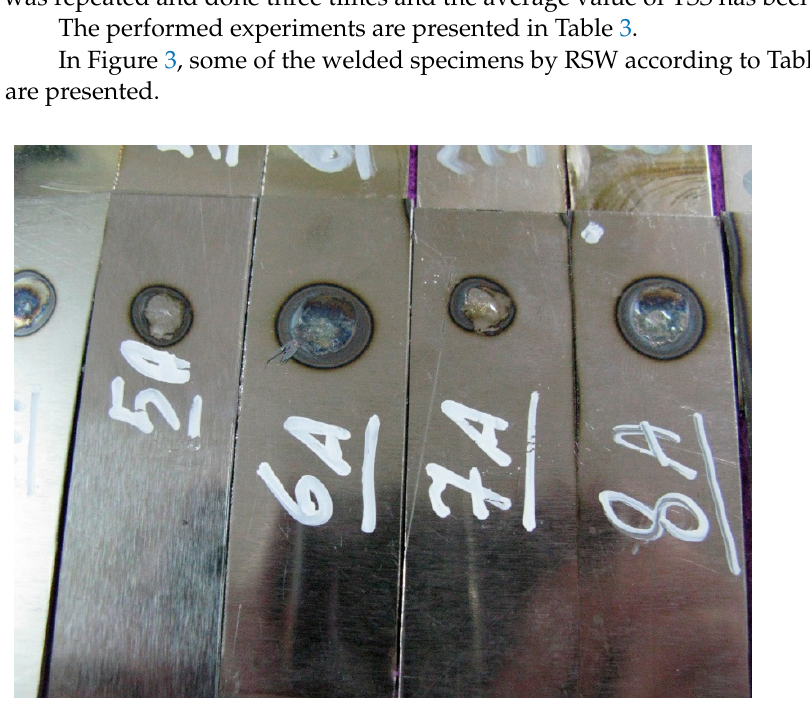
( b ) Figure 4. Two failure modes after tensile shear tests: ( a ) interfacial mode and ( b ) pullout mode. In Table 4, The TSS and failure modes after tensile-shear tests are presented for the RSW joints.